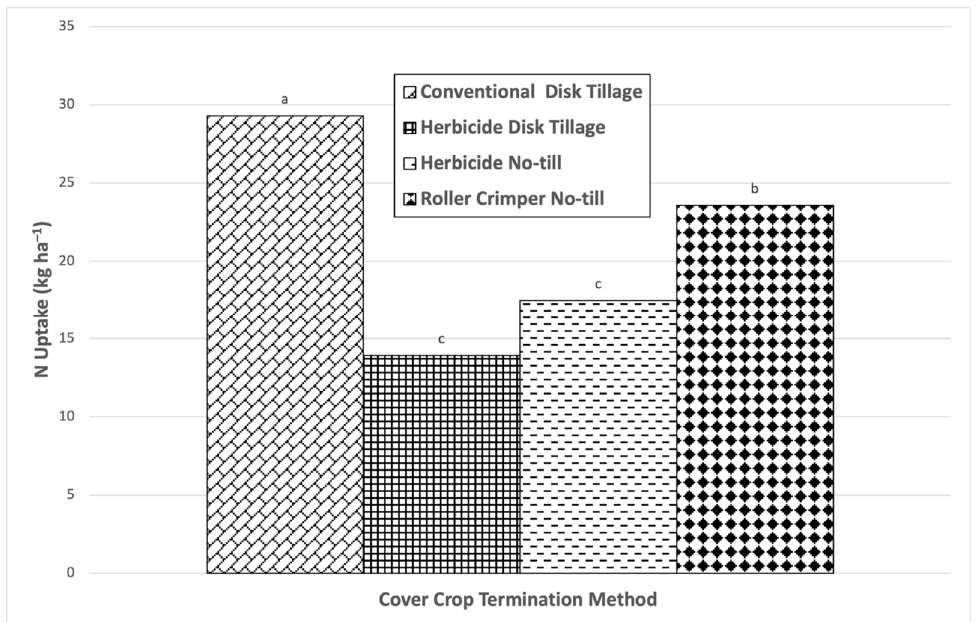
Figure 12. Mean N uptake in sweetcorn as a function of cover crop termination method in 2021. Columns marked with the same letter are not significantly different from each other according to Tukey’s HSD adjusted t tests at p ≤ 0.05.